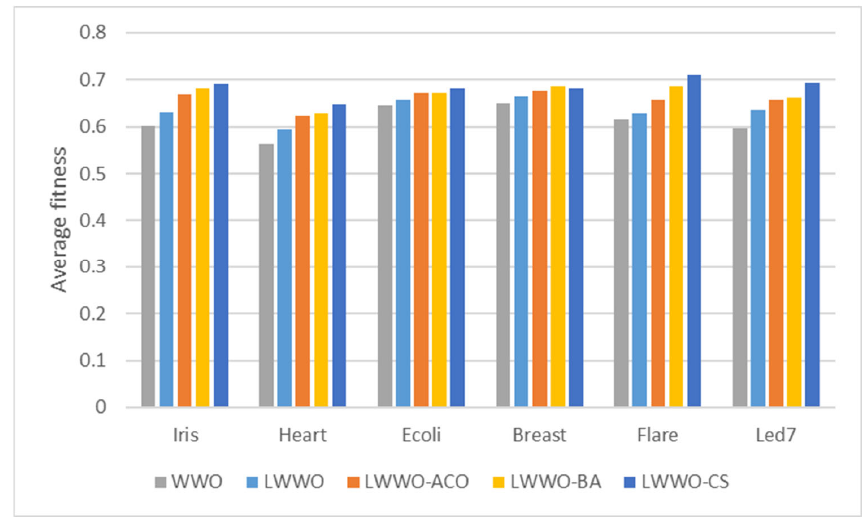
Figure 9. Comparison of average fitness.